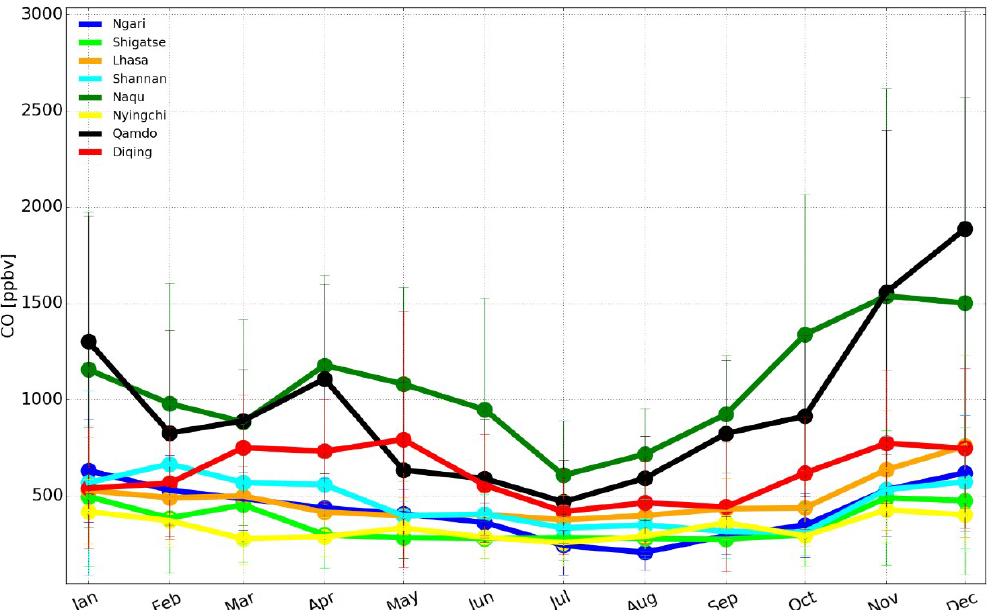
Figure 3. Monthly mean of surface CO VMR over the HTP. Vertical error bar represents 1 σ standard variation within that month. Results are based on CO VMR time series from 2015 to 2020 provided by the CNEMC network.